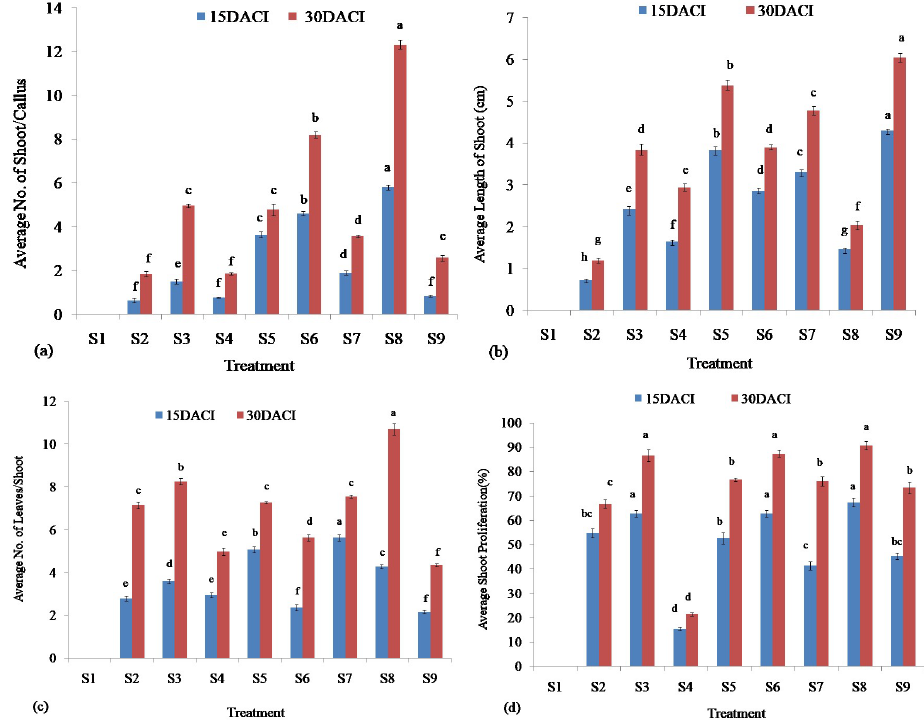
Figure 5. Shoot proliferation of stevia on MS media supplemented with different concentrations of BAP and NAA at 15 and 30 days after inoculation (DACI): ( a ) No. of shoots induced per callus; ( b ) Length of induced shoots; ( c ) No. of leaves per shoot; and ( d ) Percentage of shoot proliferation. Bars denote the mean of three replications per treatment ± SE (standard error). Mean values with the same letters are not significantly different based on the Student’s t -test at p = 0.05. The MS media augmented with different concentrations of BAP and NAA showed different levels of efficiency in generating shoots with different lengths. The MS media supplemented with BAP (10.0 mg/L) and NAA (1.00 mg/L) showed the highest efficiency in producing the average longest (4.31 cm) shoot at 15 DACI. The average longest shoot (6.05 cm) was also found from the same modified MS media at 30 DACI. The MS media